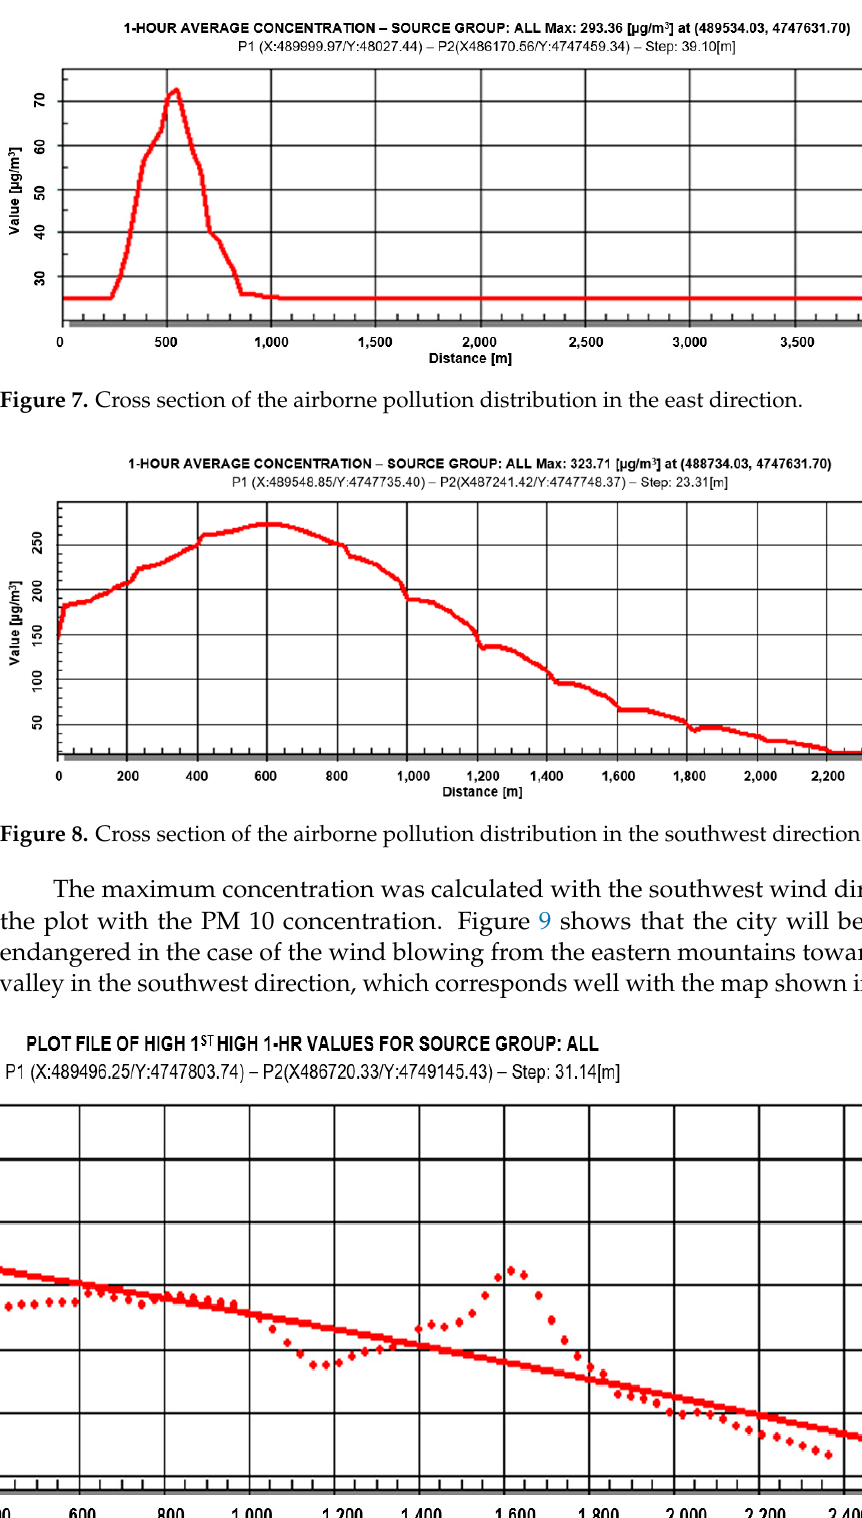
Figure 6. Average jarosite dust concentration.